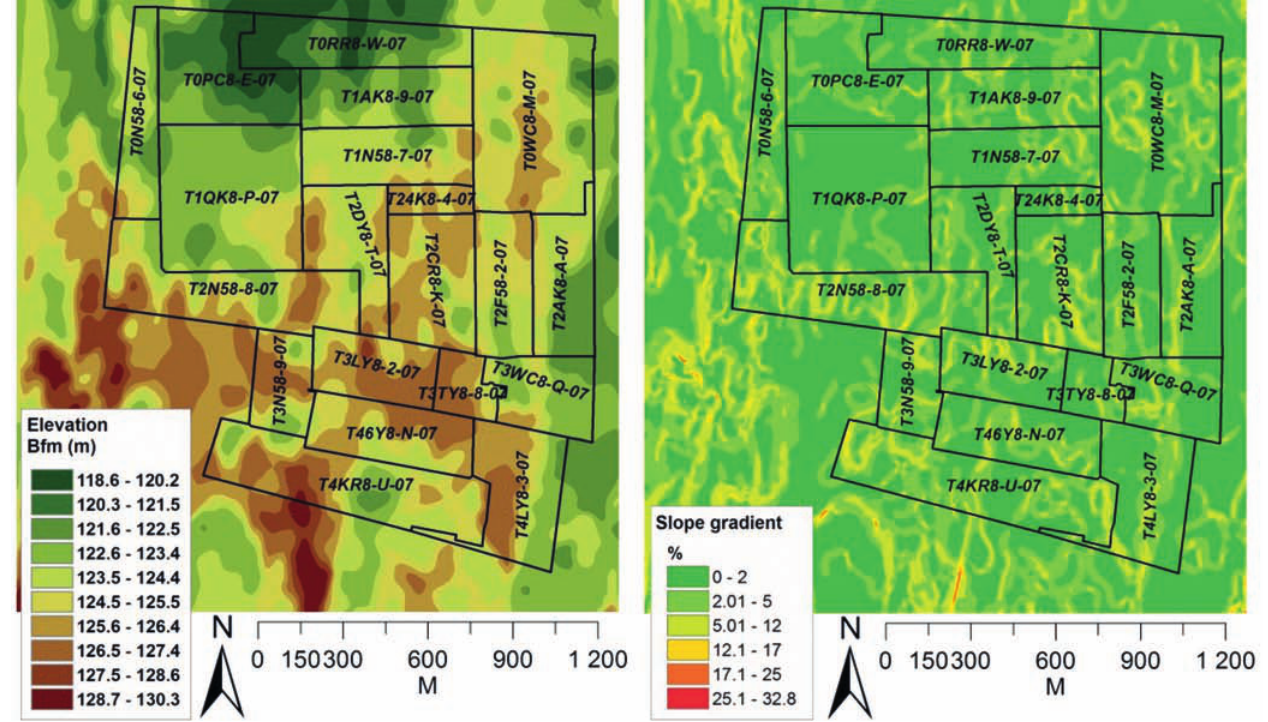
Figure 5. Digital elevation model and the slope gradient map (%) of investigation